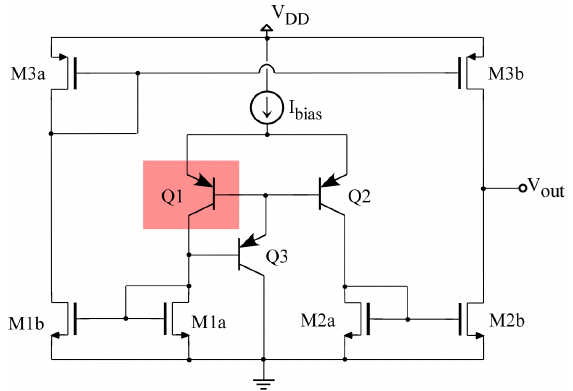
Figure 3. Schematic of the core circuit of the temperature sensor. Transistor Q1 is placed by the CUT and away from Q2 and the rest of the sensor.